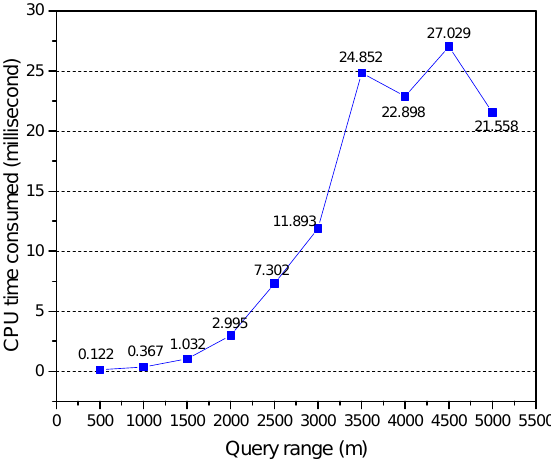
Figure 8. The CPU time needed for the calculation of the query candidate.